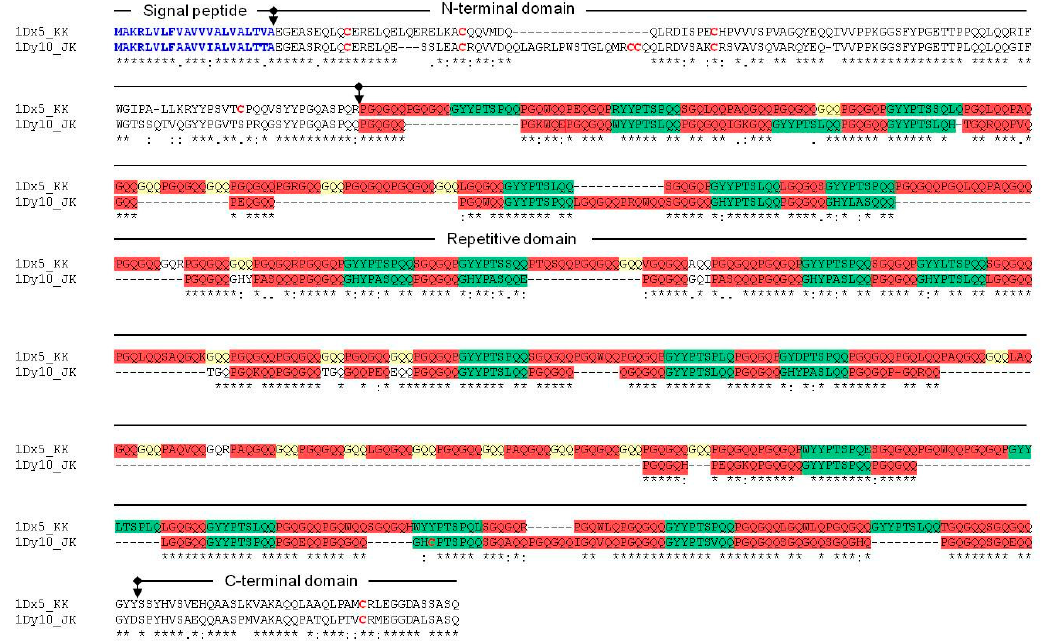
Figure 1. Amino acid sequences and primary structures of 1Dx5_KK and 1Dy10_JK. Each domain is separated with arrow. Yellow background, x-type specific GQQ repetitive peptides; green background, GYYPTSP(L)QQ; red background, PGQGQQ; red letters, cysteine residues; blue letters, signal peptides.